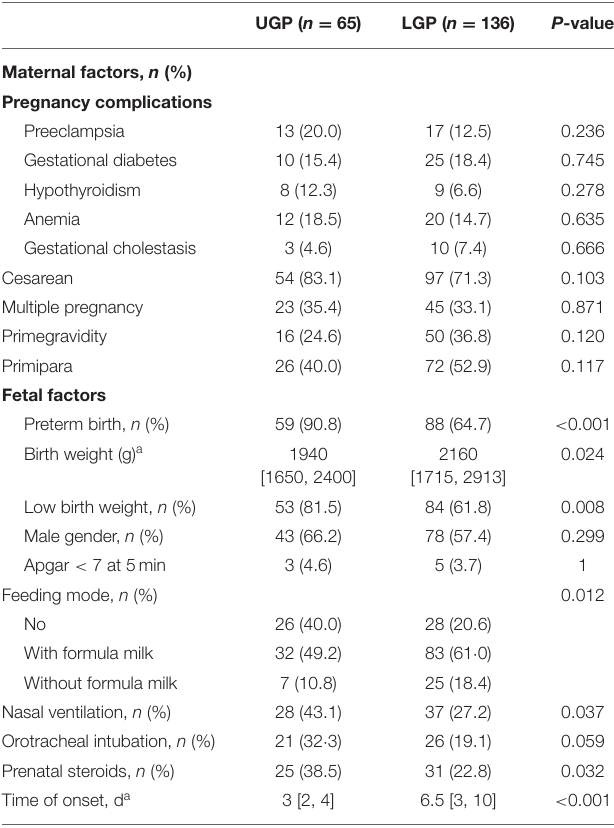
TABLE 1 | Baseline demographic of